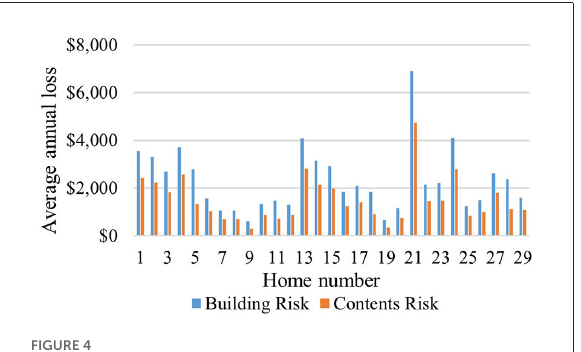
FIGURE4 Building and contents AAL at 100-year flood elevation, by